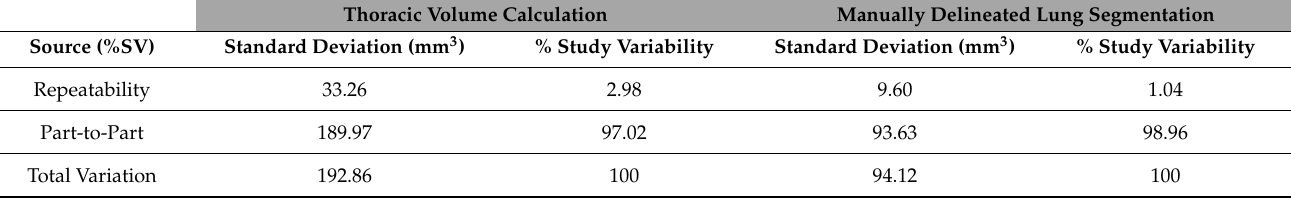
Table A1. Results of Repeatability